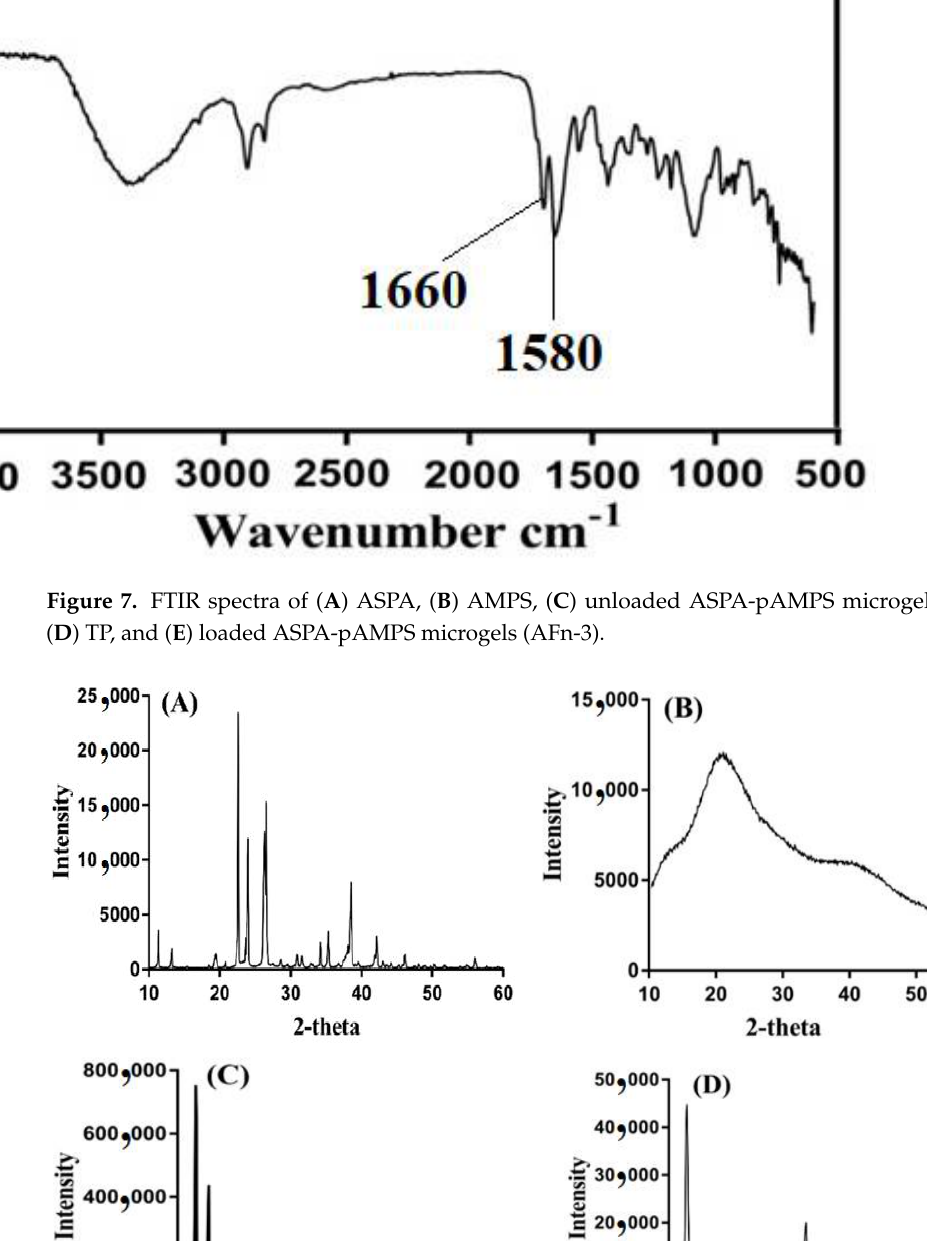
Figure 7. FTIR spectra of ( A ) ASPA, ( B ) AMPS, ( C ) unloaded ASPA-pAMPS microgels (AFn-3), ( D ) TP, and ( E ) loaded ASPA-pAMPS microgels (AFn-3).